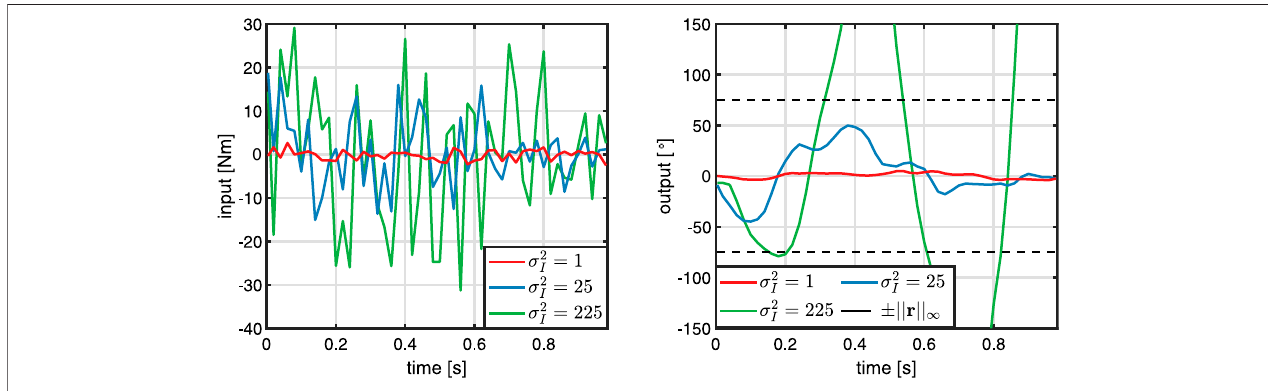
FIGURE 6 | Determination of the input variance σ 2 I : Five different values, of which only three are presented, are used to draw random input trajectories that are applied to the plant. The input variance σ 2